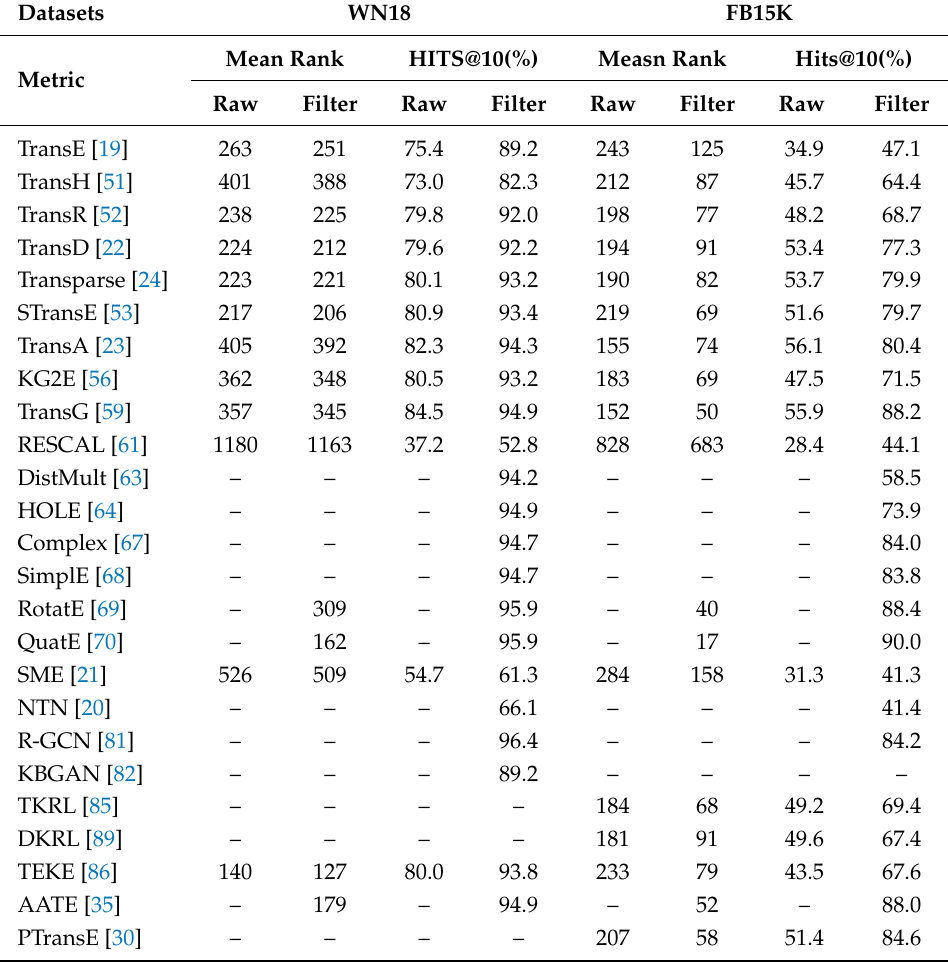
Table 6. Evaluation results on link prediction for different embedding